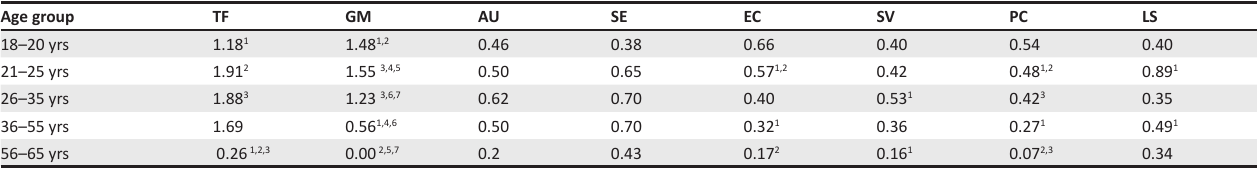
TABLE 9: Career anchors and age in the medium term (4 to 10 years). Age group